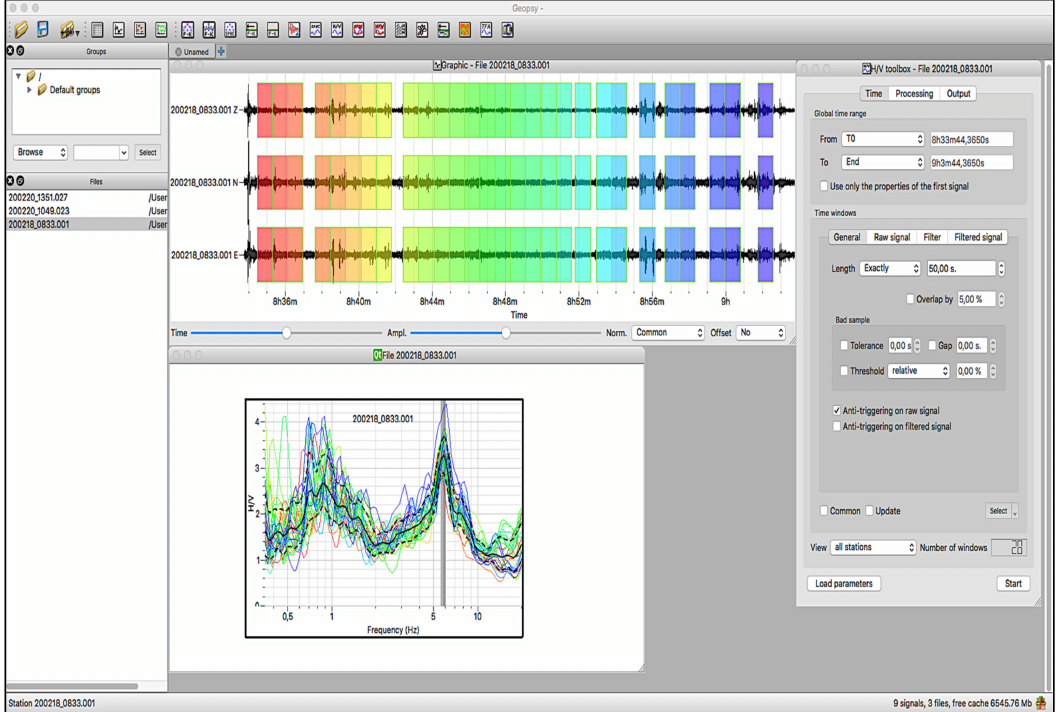
Figure 10. Snapshot example of the H/V processing using Geopsy.